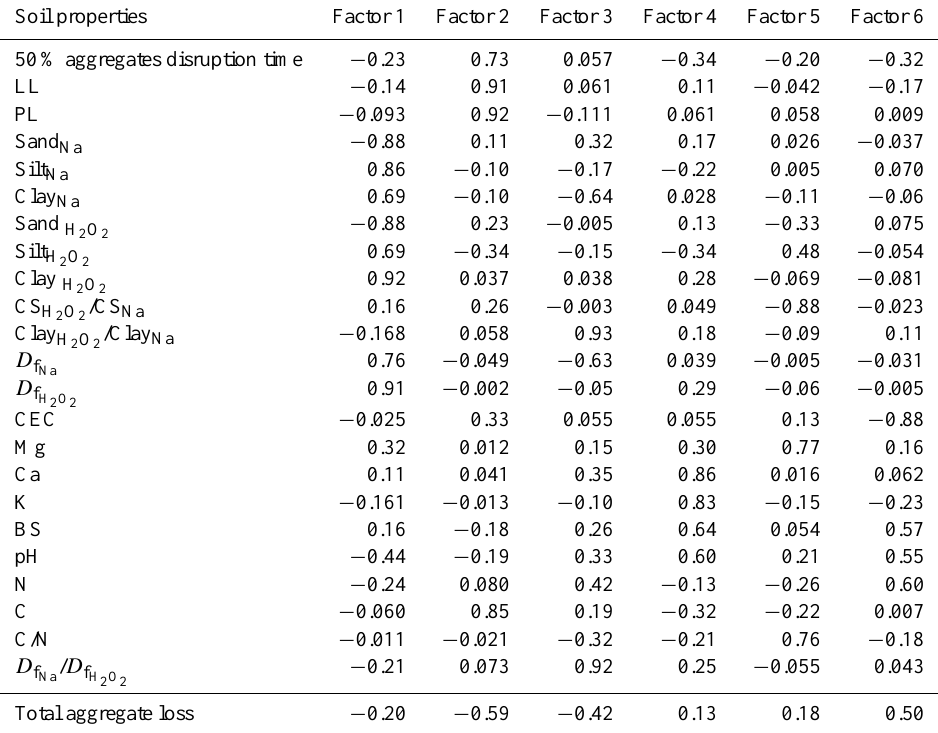
Table 9. Proportion of variance (varimax rotation) for soil properties of the retained factors, in subsoil samples ( n = 41). Soil